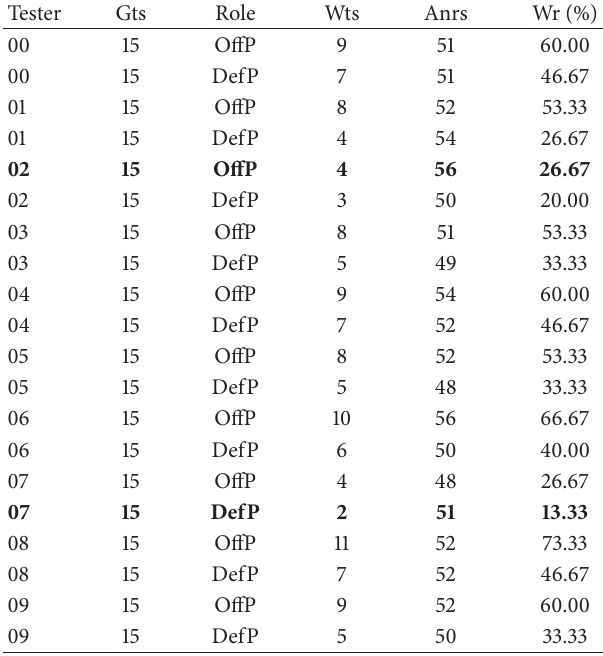
Table 5: Data records of the additional tests for selecting thresholds. A total of 1650 game-logs were used as the data source.